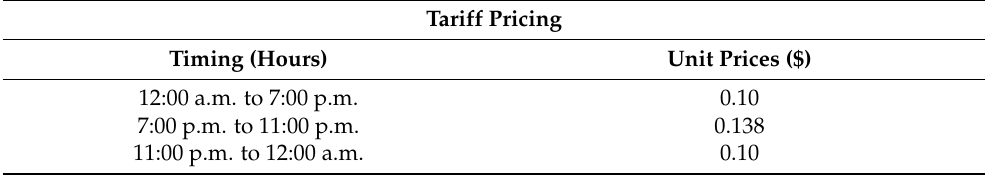
Table 2. Electricity price distribution per